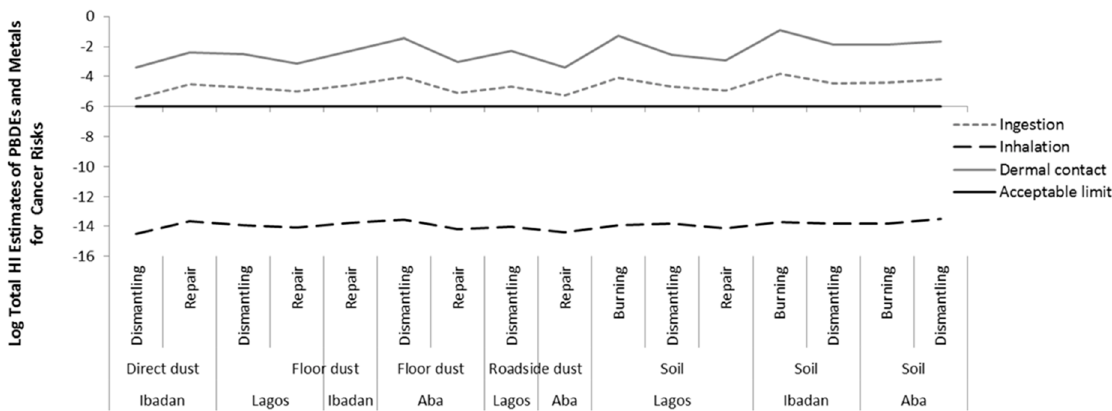
Figure 8. Hazard index (HI) for cancer risk via each exposure route of metal and Polybrominated Diphenyl Ethers (PBDEs) in soil and dust at various e -waste sites in the three locations.